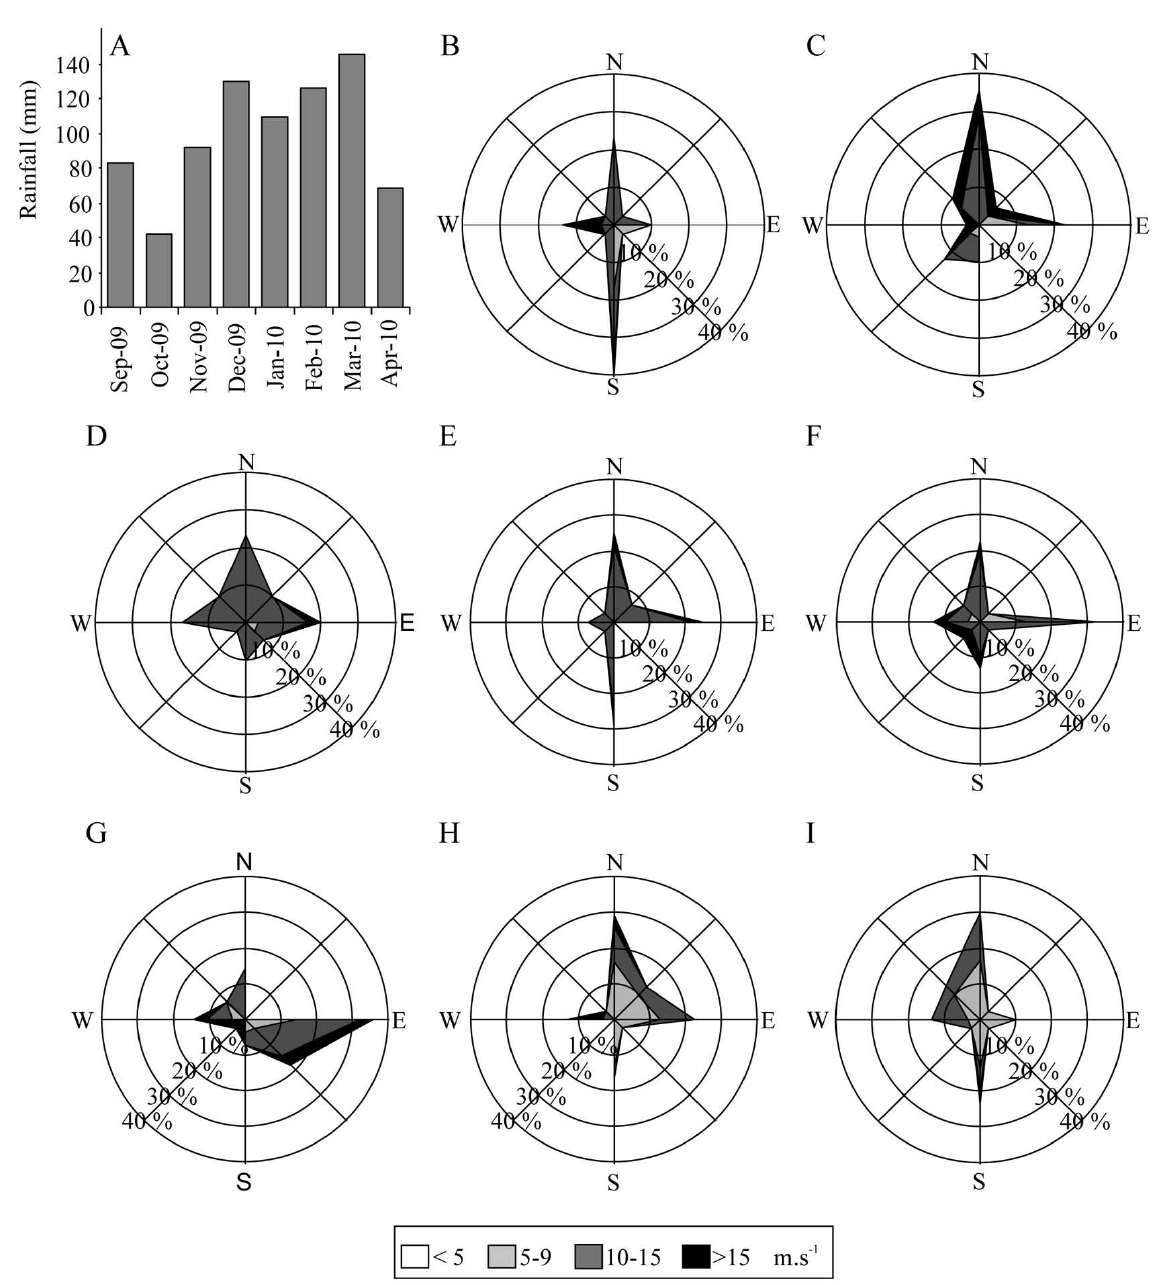
Fig. 3. – Temporal variation of rainfall amount (A), and of wind direction and speed for September 2009 (B), October 2009 (C), November 2009 (D), December 2009 (E), January 2010 (F), February 2010 (G), March 2010 (H) and April 2010